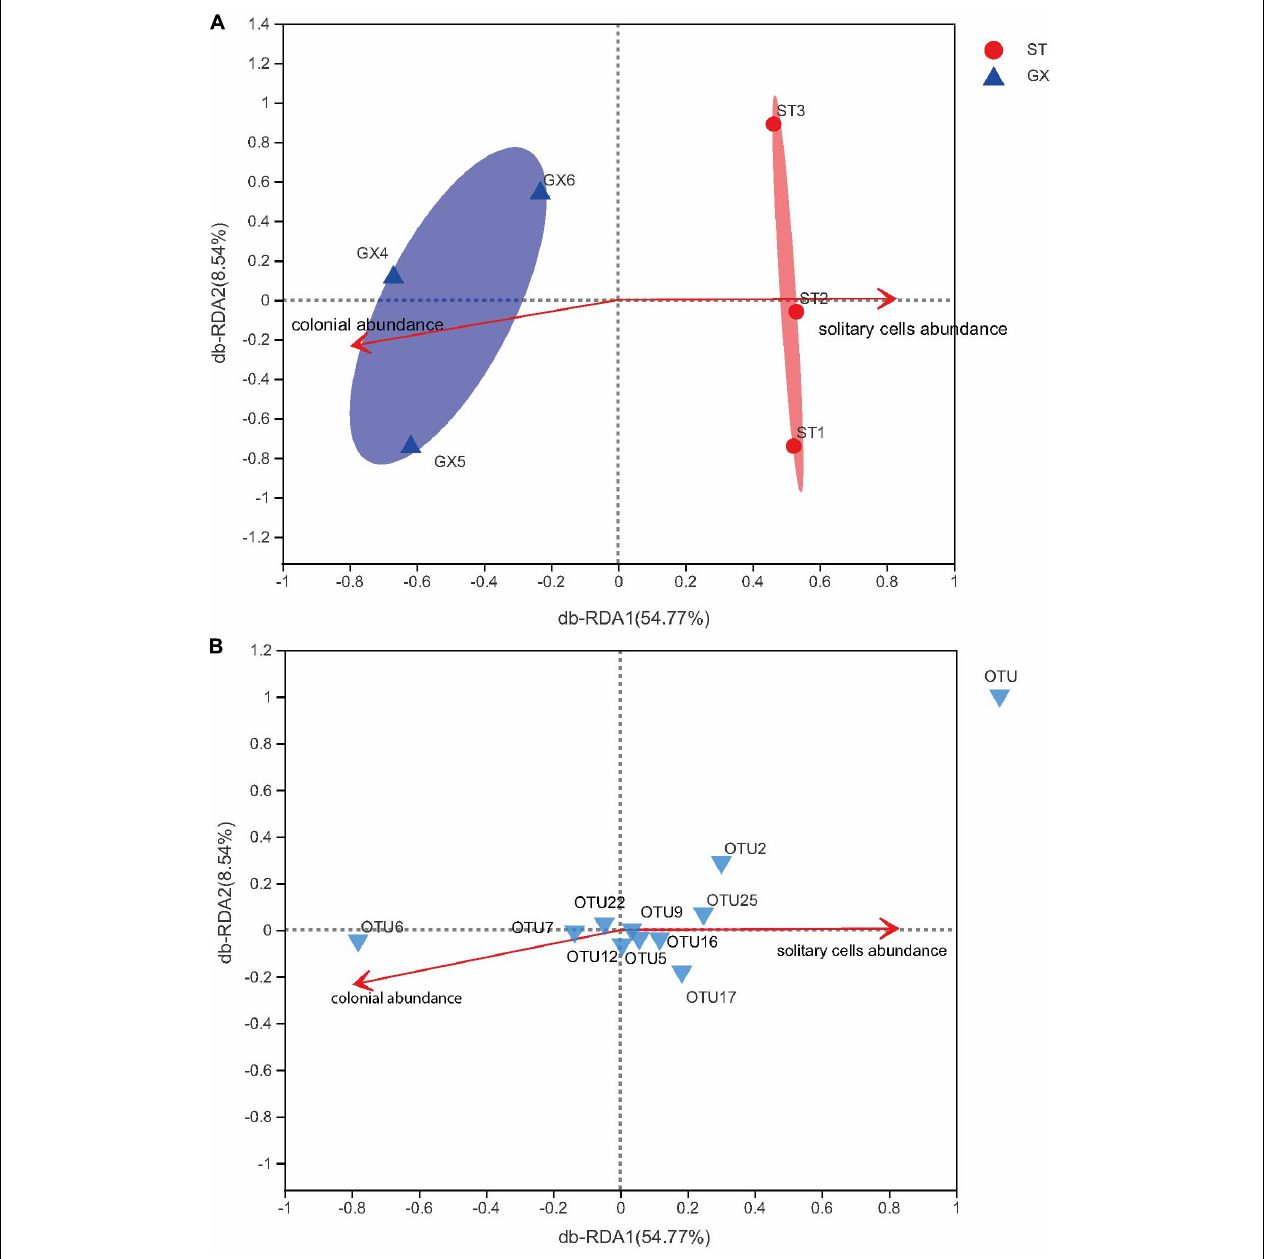
FIGURE 7 | Distance-based redundancy analysis (db-RDA) ordination plots of bacterial community variation at the OTU level. (A) The relationships of Phaeocystis globosa growth indices and community composition. The relationships of P. globosa growth indices and the 10 most abundant OTUs (B) . GX, P . globosa GX strain co-culture; ST, P . globosa ST strain